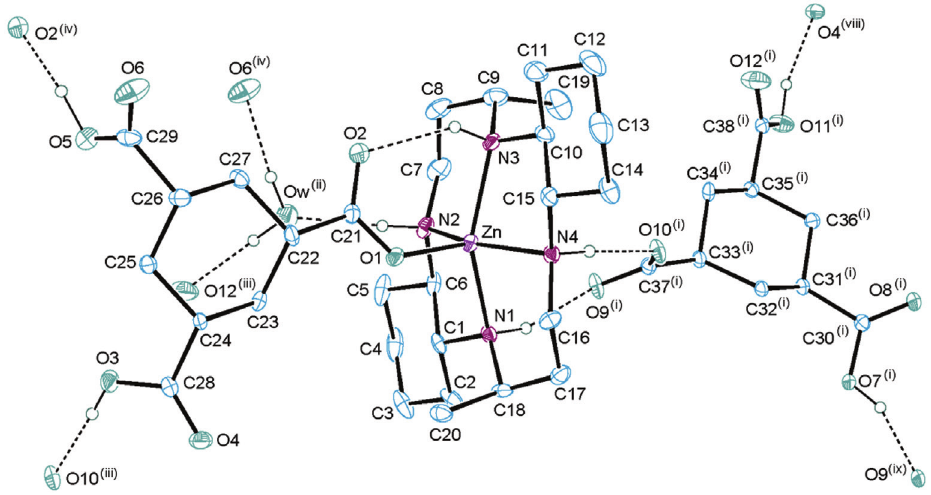
chtc - )]H chtc - ·H O ( 1 ) with the atomic numbering scheme. 2 2 2